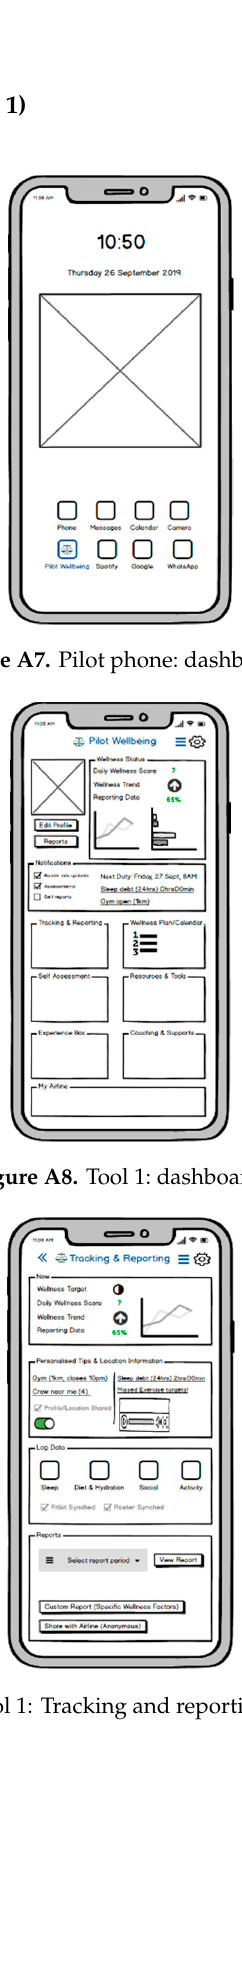
Figure A10. Tool 1: my airline dashboard. Figure A11. Tool 1: anonymous safety reporting. Appendix J: Extended I am Safe Checklist Table A6. Extended I am Safe Checklist. I